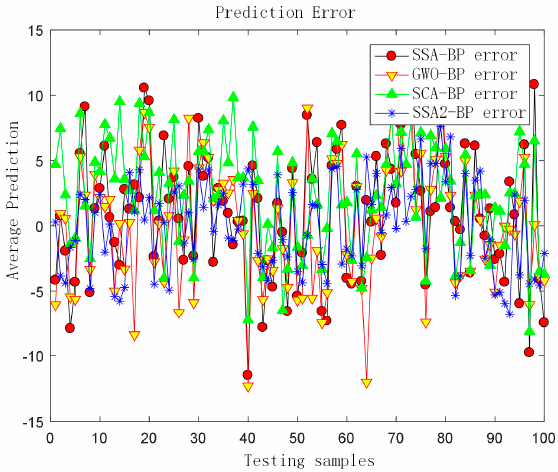
Figure 10. Error comparison chart.